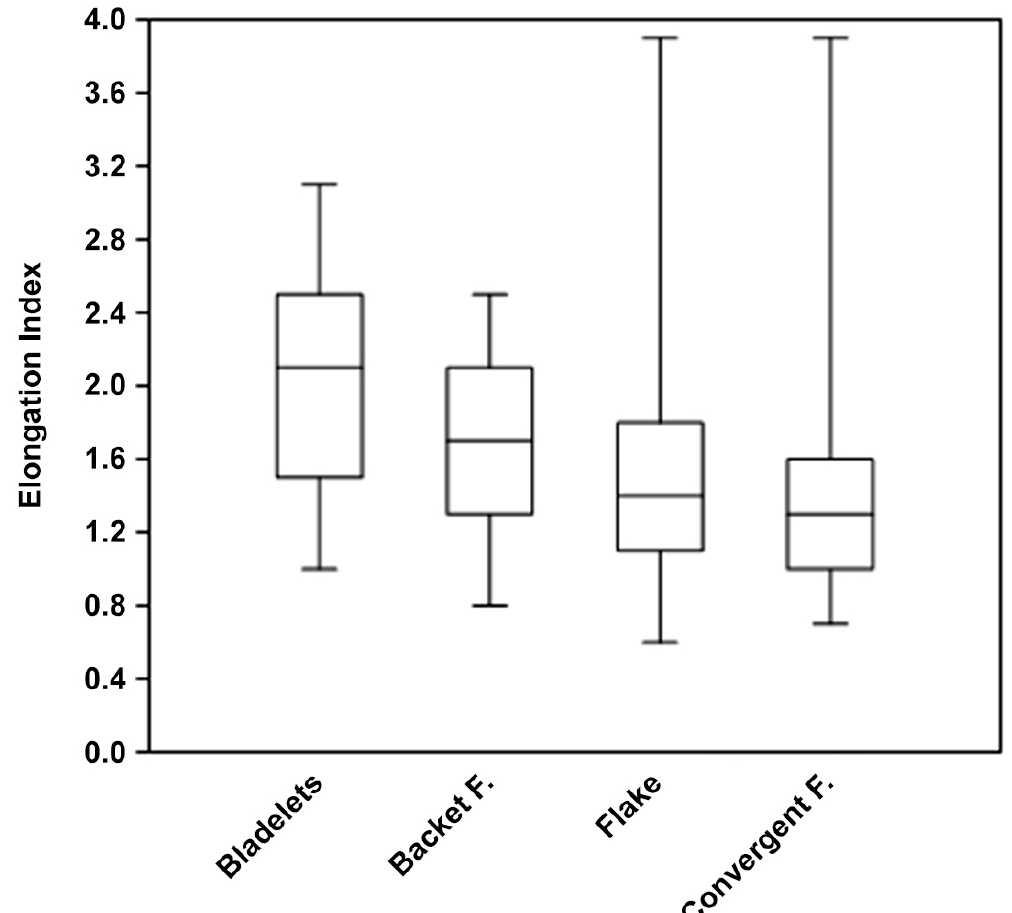
Figure 6: Elongation Index target flakes. Bladelets (N = 26), backed flakes (N = 37), flakes (N = 200) and convergent flakes (N =